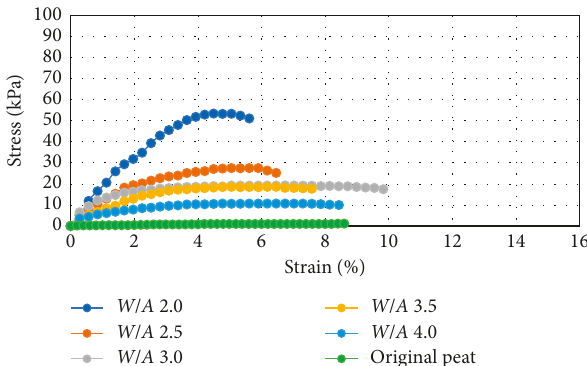
Figure 2: Stress vs. strain of peat A specimens after 56 days air-